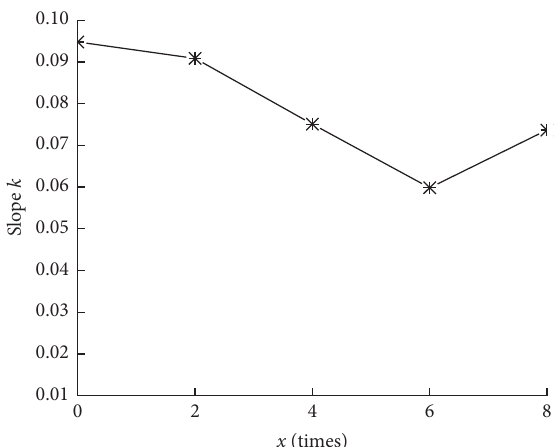
Figure 8: Relationship between the slope of the compression curve and x .